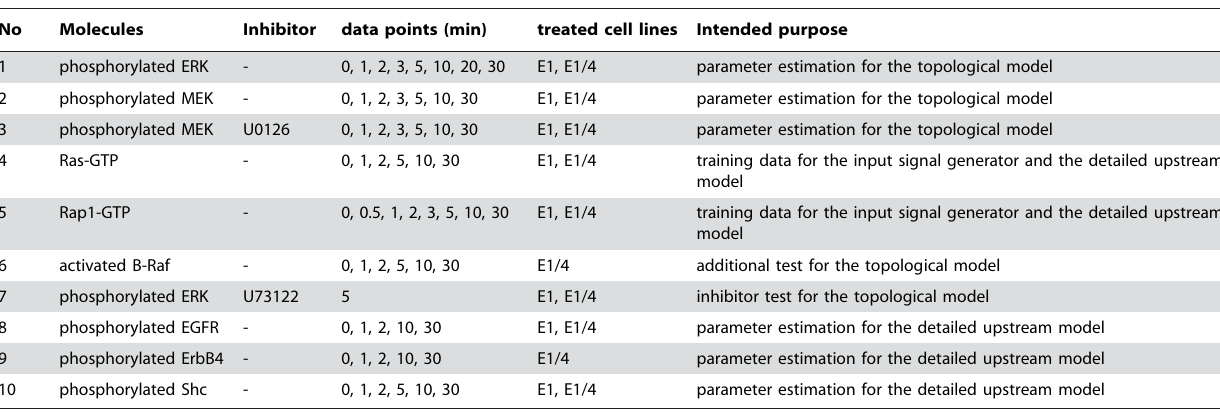
Table 1. Time-course data from Western blot